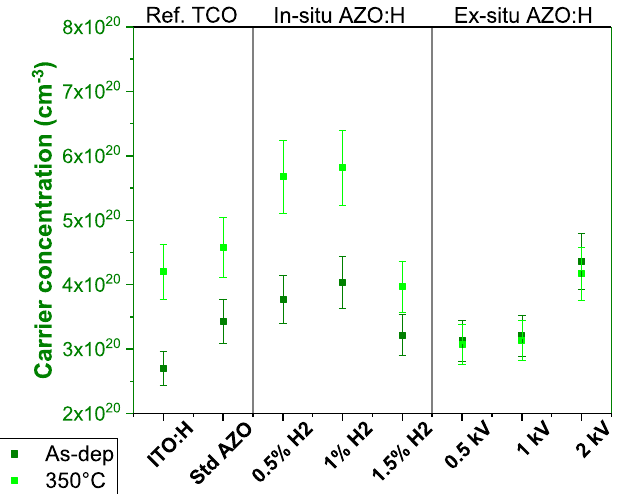
Fig. 3. Variation of R sheet values with the TCO composition and the annealing at 350 ° C.